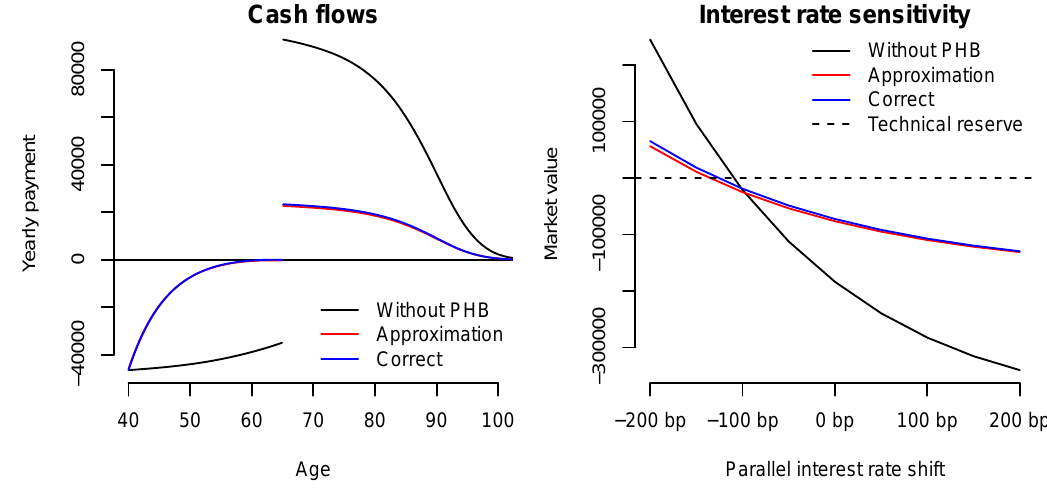
Figure 7. Cash flows (left) and market value for different parallel shifts in the interest rate structure (right), measured in basis points. In the figures, we see that the modeling of policyholder behavior has a major impact. Furthermore, it seems difficult to distinguish the approximate and the correct method using the eye-ball norm only. The approximation yields a slightly larger cash flow and market value than the correct modeling